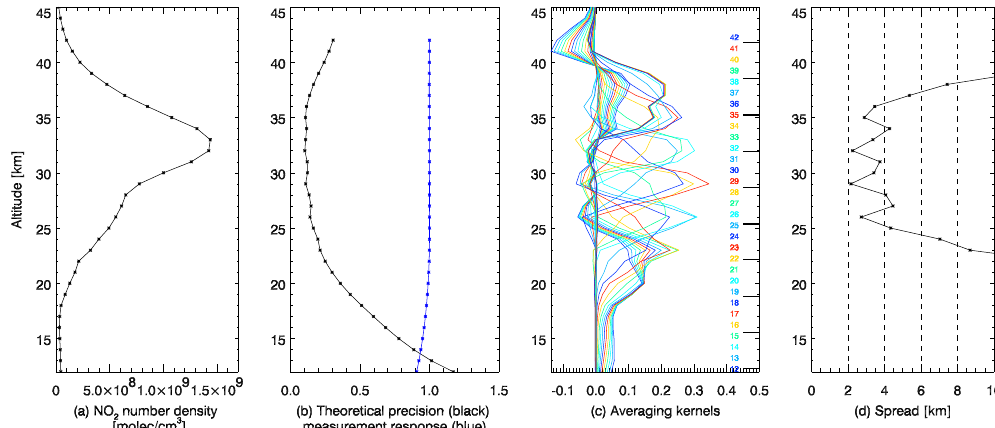
Fig. 2. Similar to Fig. 2, a retrieved NO 2 profile is analyzed. However, this example (measurement performed on 18 June 2005) is obtained at 1.45 ◦ N. Panel (a) shows the NO 2 profile retrieved with SCIATRAN, panel (b) theoretical precision (black) and measurement response (blue), panel (c) averaging kernels and panel (d)